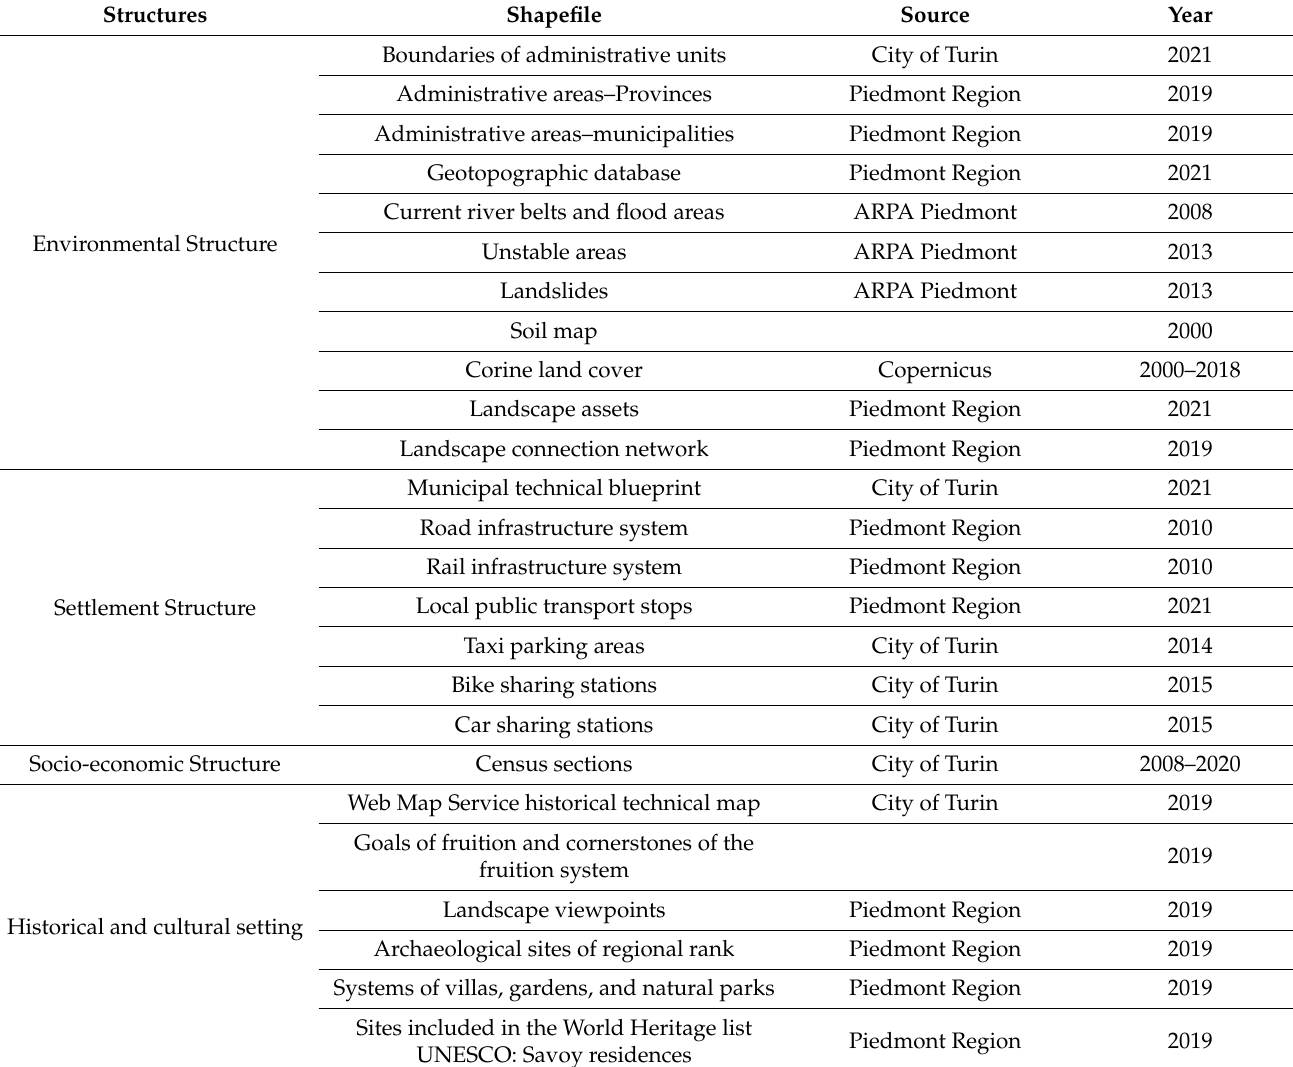
Table 1. List of shapefiles, broken down by assets, used for analysis purposes